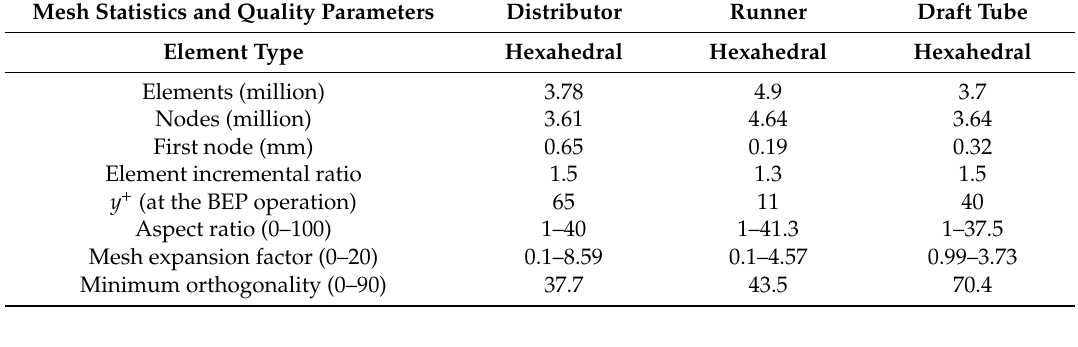
Table 2. Statistics and quality of the mesh provided for the numerical simulations.